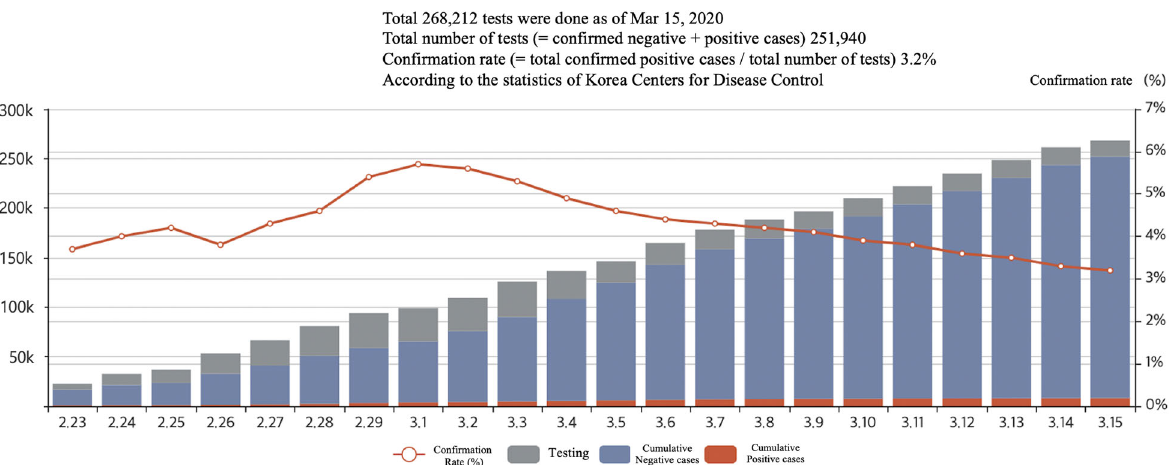
Fig. 1 Status of COVID-19 diagnostic tests in S. Korea. According to Korea Centers for Disease Control, total 268,212 COVID-19 tests were done as of 15 March 2020. Data and fi gure derived from the Korea Centers for Disease Control.